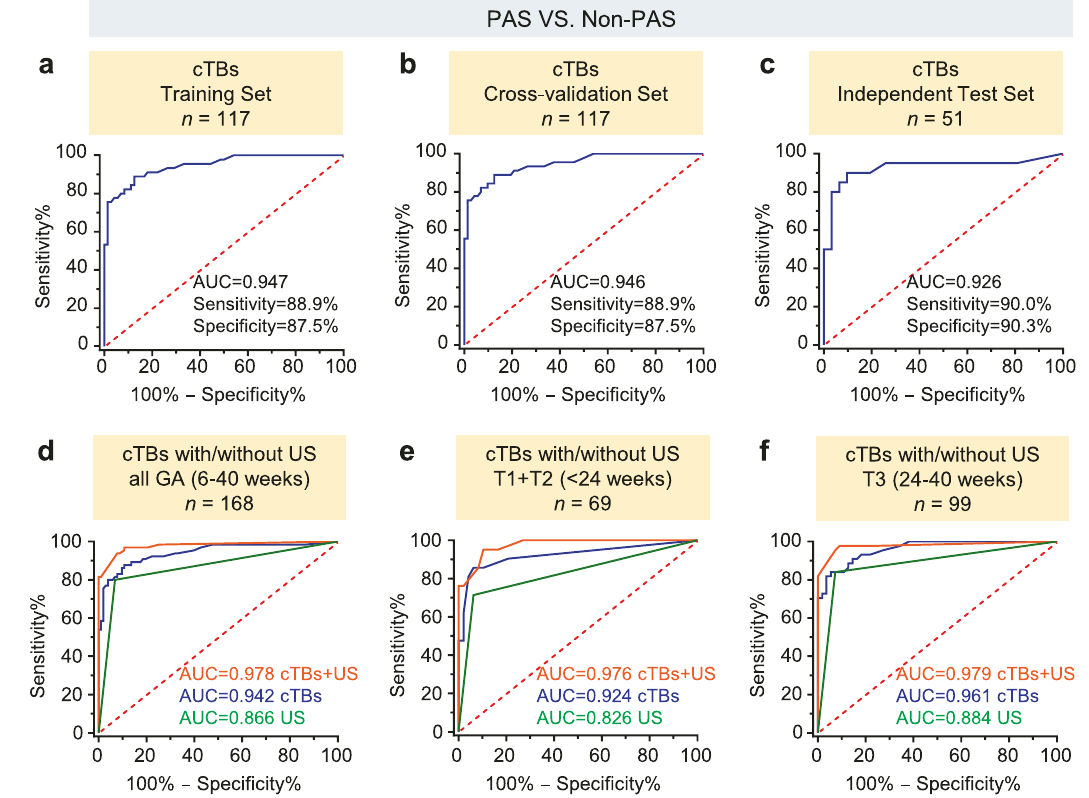
Fig. 6 Receiver operating characteristic (ROC) curves of cTB assay with/without ultrasound. ROC curves of cTB assay analyzed in a the training set, b after leave-one-out cross validation, and c independent test set for distinguishing PAS from non-PAS during all gestational age (GA, 6 ‒ 40 weeks). Area under the curves (AUC) with the sensitivity and speci fi city of the assays at the optimal cutoffs are listed for each graph. Comparison of ROC curves of cTB assay with or without ultrasound (US) for distinguishing PAS from non-PAS in d all GA (6 ‒ 40 weeks), e earlier GA (The fi rst and second trimester, T1 + T2 < 24 weeks), and f late GA (T3 ≥ 24 weeks). AUC for each diagnostic model is listed for each ROC curve. Source data are provided in the Source data fi